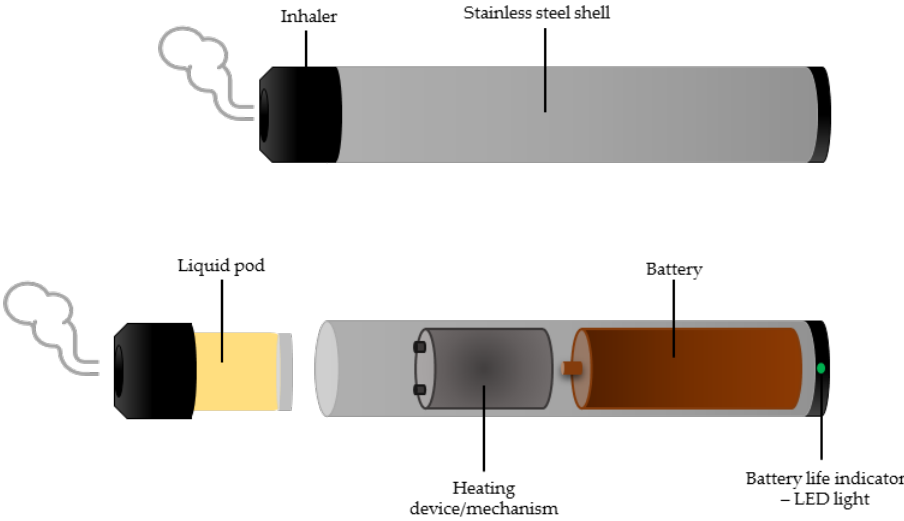
Figure 1. General structure of ENDS (e-cigarettes) comprised of a liquid pod, heating mechanism, battery and a battery life indicator using a LED light.